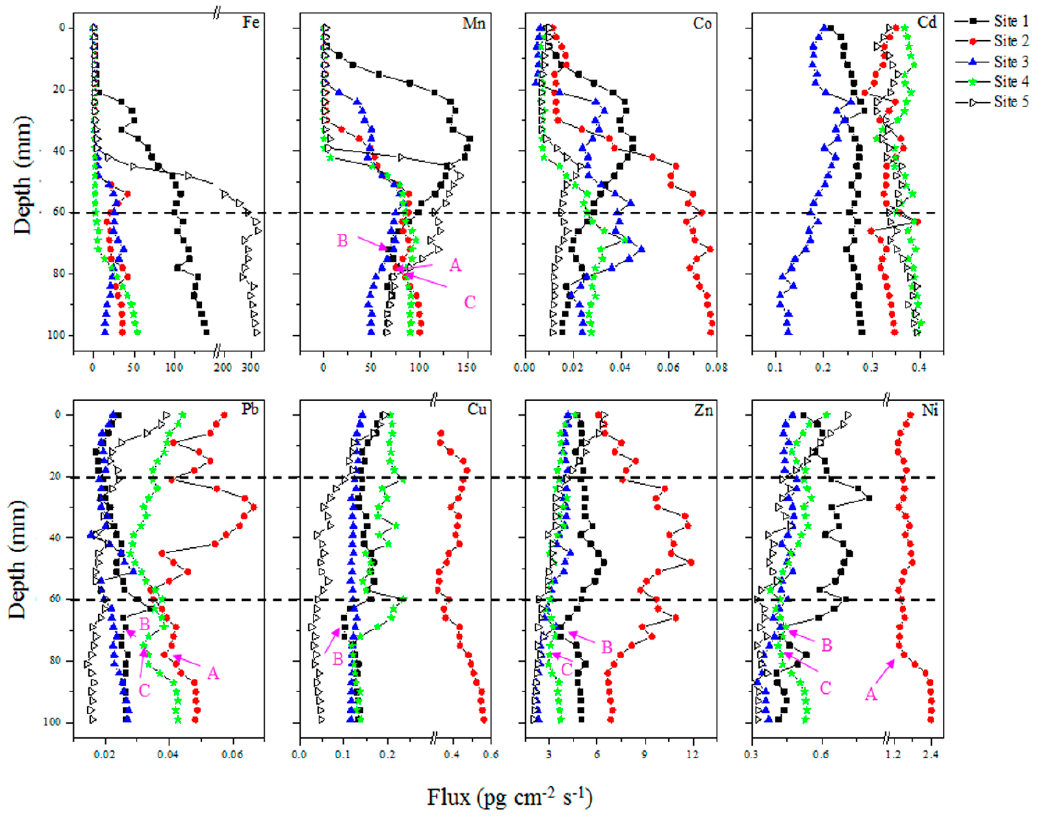
Figure 5. Distributions of DGT-labile flux ( F DGT , pg·cm − 2 ·s − 1 ) of metals in sediments. The marked letters show corresponding minima between Mn and other metals.